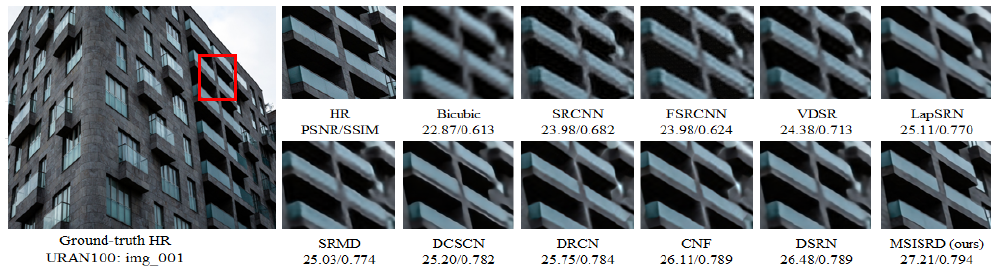
Figure 12. Visual performance of the “img-001” from URBAN100 [23] dataset with 8 × scale factor enlargements